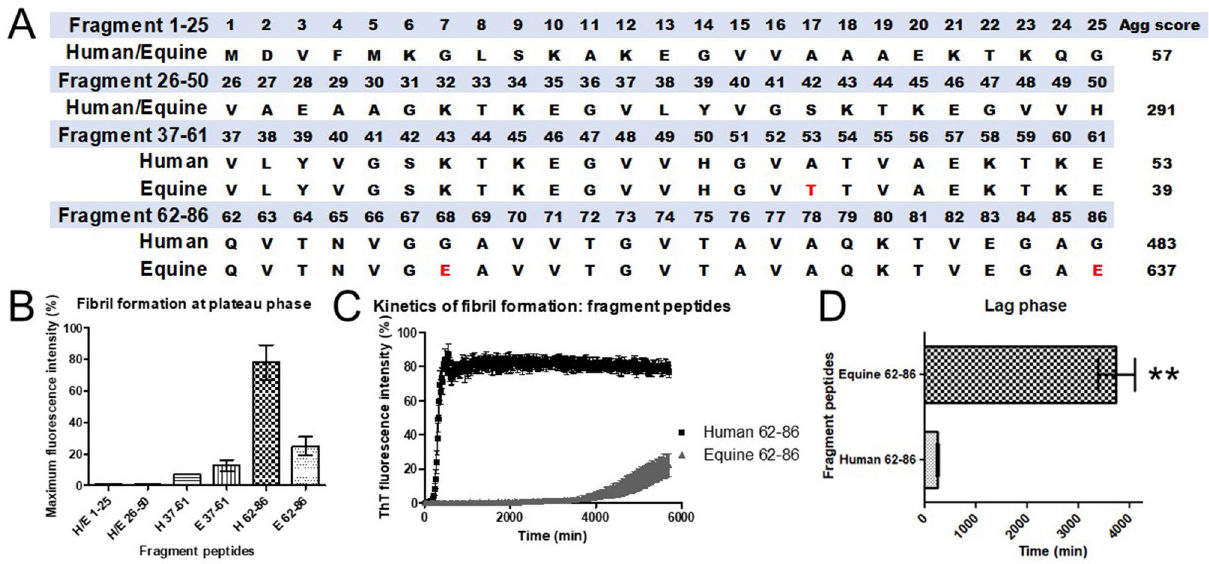
Figure 4. Equine α-synuclein (α-syn) fragment peptide 62–86 generated fibrils after a longer lag phase period in comparison with its human counterpart using ThT binding assays. ( A ) Sequence of α-syn synthetic fragment peptides used to investigate aggregation propensity of equine α-syn. Aggregation scores determined by Tango bioinformatic program are provided in the right-sided column for each peptide fragment. Fragments exhibiting an aggregation score of 30–60 were selected as negative controls. Fragments with scores near or above 300 were further analyzed with biophysical assays to study the propensity of aggregation in vitro. ( B ) The maximum of fluorescence intensity at plateau phase of selected fragment peptides: bars show mean of fluorescence with error bars for SEM of three replicates. ( C ) Kinetics of α-syn fibril formation of human and equine fragment peptides 62–86. Data represent the mean of the fluorescence intensity with error bars for SEM obtained from three replicates. ( D ) Lag time required for fibril elongation of equine fragment peptide 62–86 is longer than for the human fragment peptide 62–86. Two-way analysis of variance with Bonferonni post-hoc testing to compare replicate means by row. Differences were considered statistically significant at * p < 0.05 and ** p <